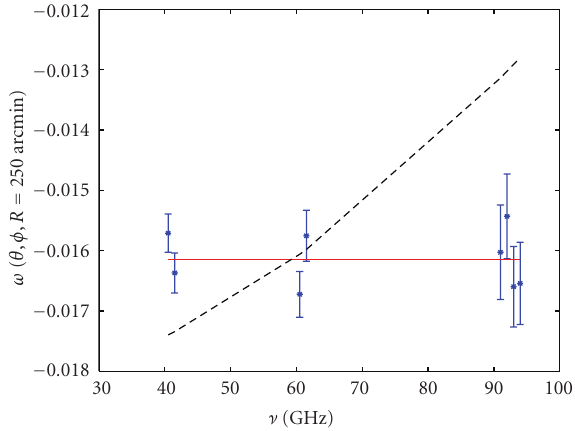
Figure 11: Best-fit of the WMAP data—across the 8 di ff erence assemblies for the Q-, V-, and W-bands—to a CMB (solid line) and a SZ spectra (dashed line). The fit is performed to the minimum amplitude of the Cold Spot in wavelet space, at a scale of R = 300 arcmin. Error bars are obtained from Gaussian